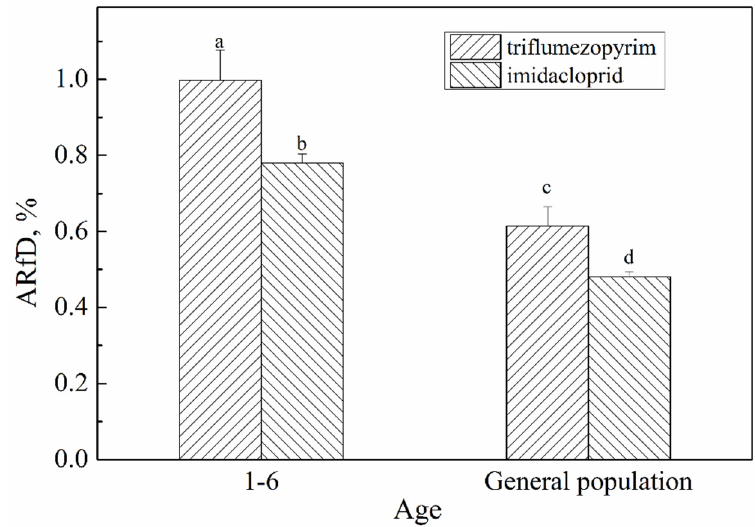
Figure 7. %ARfD of triflumezopyrim and imidacloprid in rice for different ages. The letters (a, b, c and d) indicate a significant difference at the 1% level.